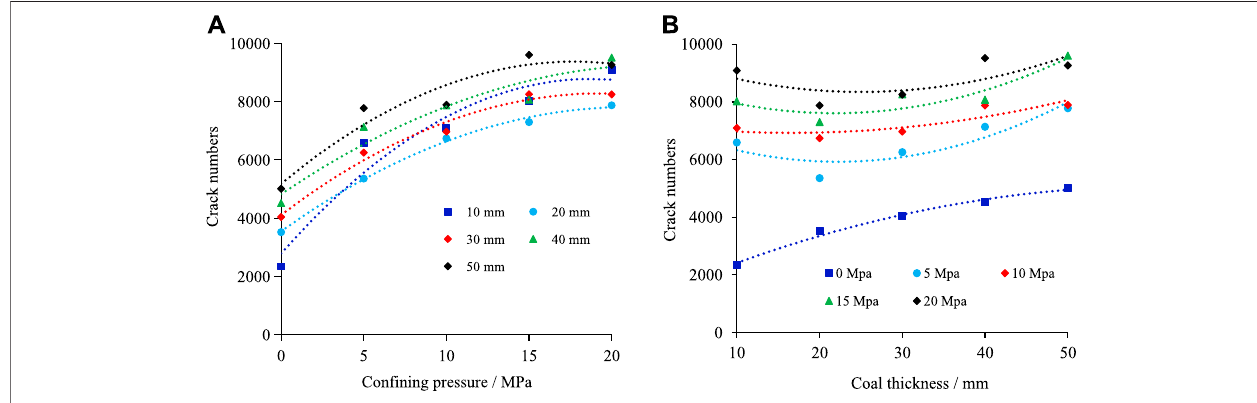
FIGURE 9 | Crack number of the RCR composites at different inclined coal seam thicknesses and different con fi ning pressures. (A) In fl uence of different con fi ning pressure; (B) In fl uence of different coal thickness.